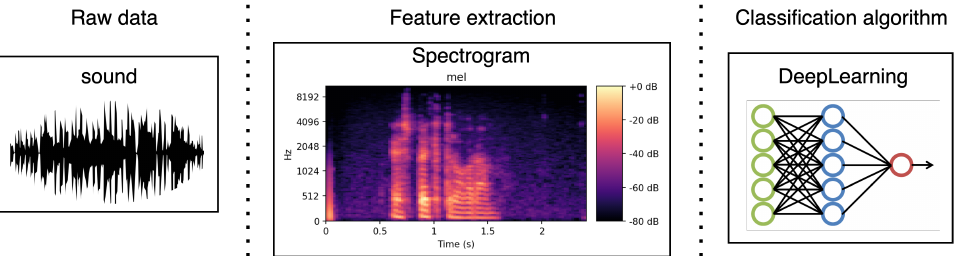
Figure 2. Pipeline of a basic procedure in audio classification problems. First, raw data are identified, i.e., the wav audio itself. Then, the characteristics are extracted with a tool, the spectrogram, through librosa [58], in this case. Finally, the classification problem is carried out, in this case, using neural networks. Color in Deep Learning diagram means input, intermediate and output